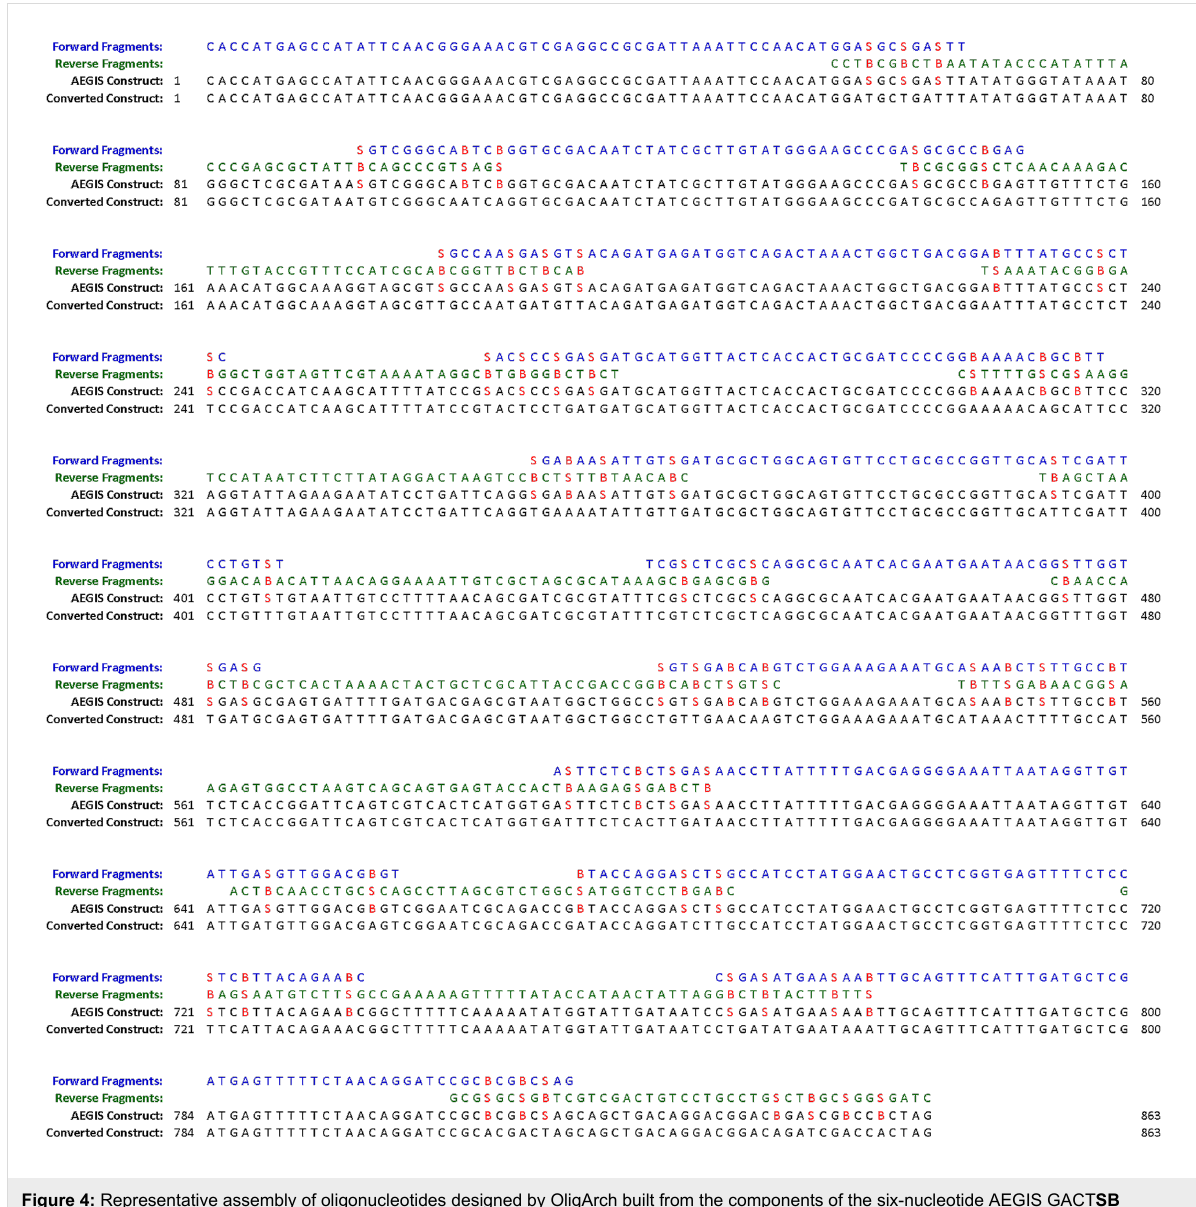
accessible at http://bioinformatics.ffame.org/bioinformatics/